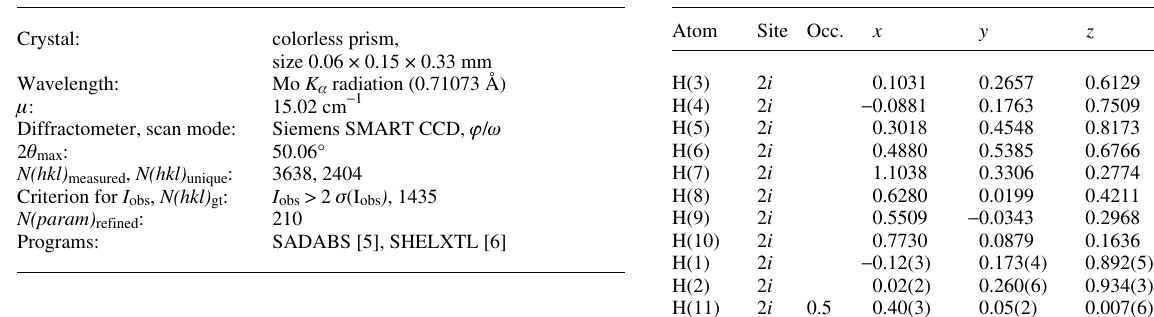
Table 1. Data collection and